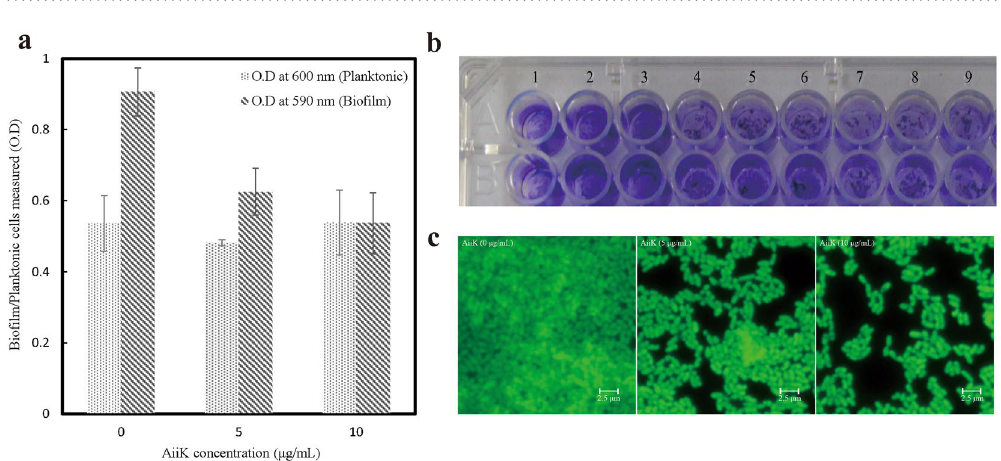
Figure 6. Effect of AiiK on biofilm formation in P. aeruginosa PAO1. ( a ) Biofilm formation by P. Aeruginosa PAO1 represented by crystal violet staining and planktonic cells of P. Aeruginosa PAO1. ( b ) The crystal violet staining of biofilm formed by P. aeruginosa PAO1. Lanes 1–3: 0 μ g/mL of AiiK; Lanes 4–6: 5 μ g/mL of AiiK; Lanes 7–9: 10 μ g/mL of AiiK. ( c ) Fluorescence microscopy for visualization of biofilm formation by P. aeruginosa PAO1 stained with acridine